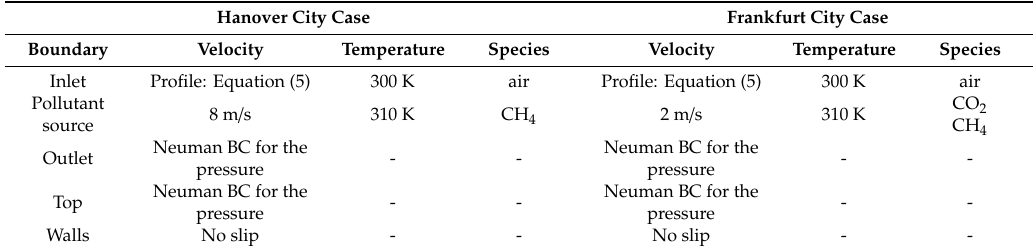
Table 2. Initial and boundaries conditions used for Hanover and Frankfurt